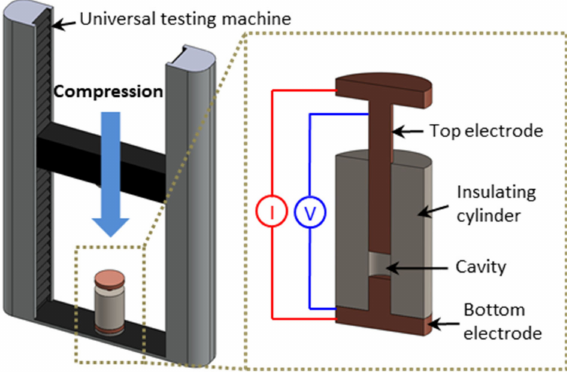
Figure 1. Schematic illustration of the apparatus for electromechanical